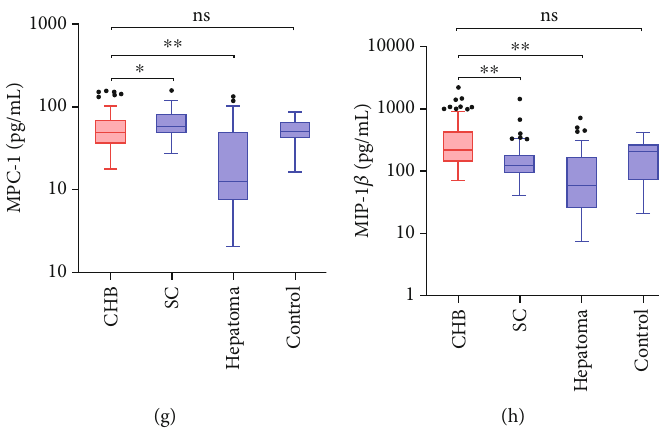
Figure 1: Circulating cytokine and chemokine levels in patients with chronic hepatitis B (CHB), HBV spontaneous clearance (SC), and HBV-related hepatoma and in healthy controls. It shows circulating cytokine IL-1 β (a), IL-6 (b), IL-17 (c), and IL-10 (d) and chemokine IL-8 (e), IP-10 (f), MCP-1 (g), and MIP-1 β (h) levels in di ff erent groups. Each box plot represents the median, interquartile range, and the minimum and maximum values. The Mann – Whitney U test was used to compare the CHB (red) and other groups (blue), and Bonferroni correction was applied to adjust for multiple comparisons. ∗ P value < 0.05, and ∗∗ P value < 0.001. ns: Not signi fi cant. Table 3: Multivariate logistic regression analysis between cytokine/chemokine levels and chronic hepatitis B outcomes. SC Hepatoma Variables OR (95% CI) P OR (95% CI)